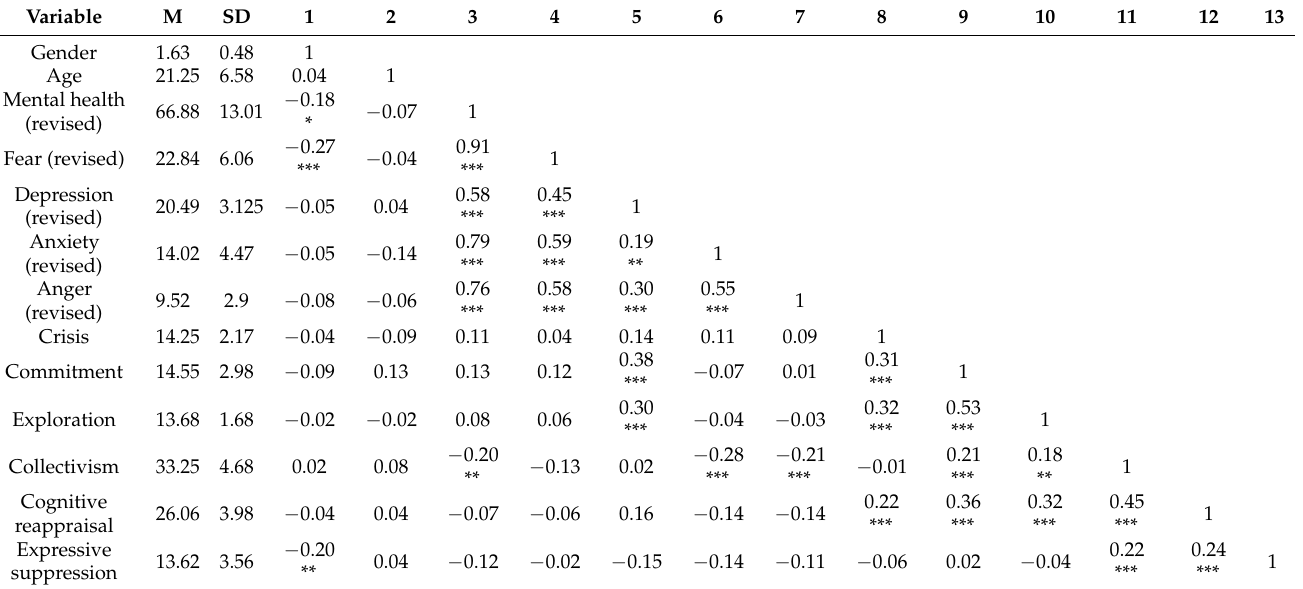
Table 1. Results of descriptive statistics and correlation analysis for each variable (corrected by Bonferroni Correction) (N =